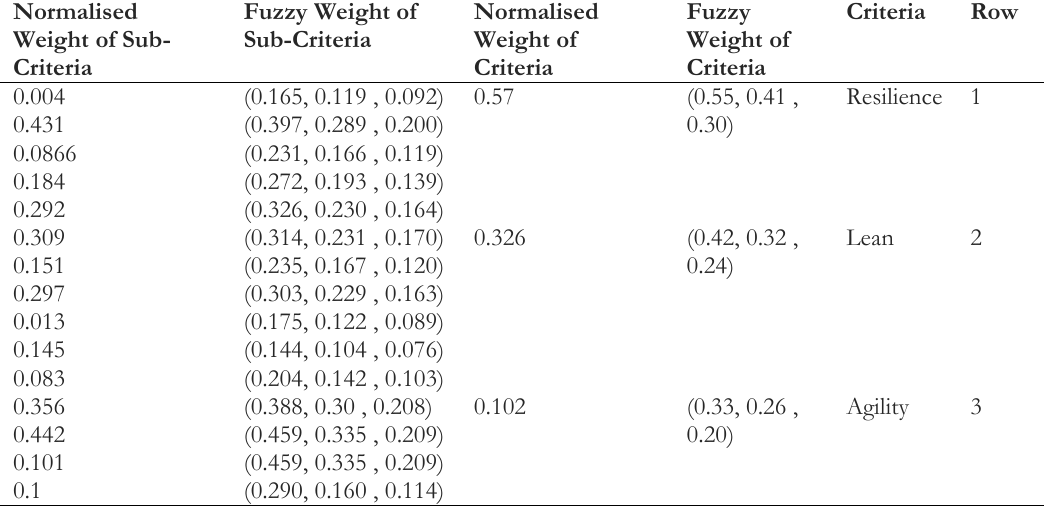
Table 8. Fuzzy and normalised weights of criteria and sub-criteria.